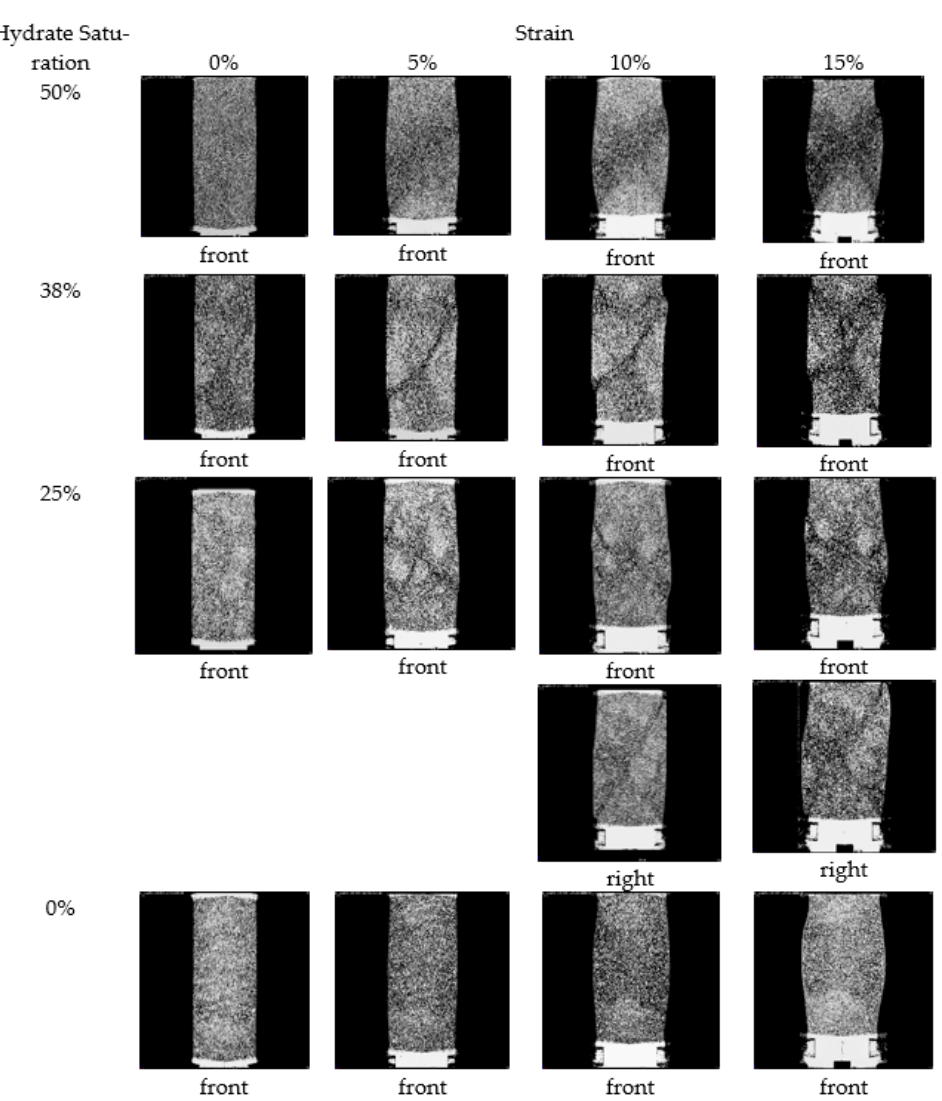
Figure 5. CT images with strain and hydrate saturation (σ 3 = 1MPa). The image is the superposition of the images along the thickness of the sample, That means these images are not some sections. Note: (1) This picture is a longitudinal section, and ‘front’ or ‘right’ mean the different directions of CT scan to the samples; (2) The white indicates the sand and the black indicates the hydrate, water and pore.